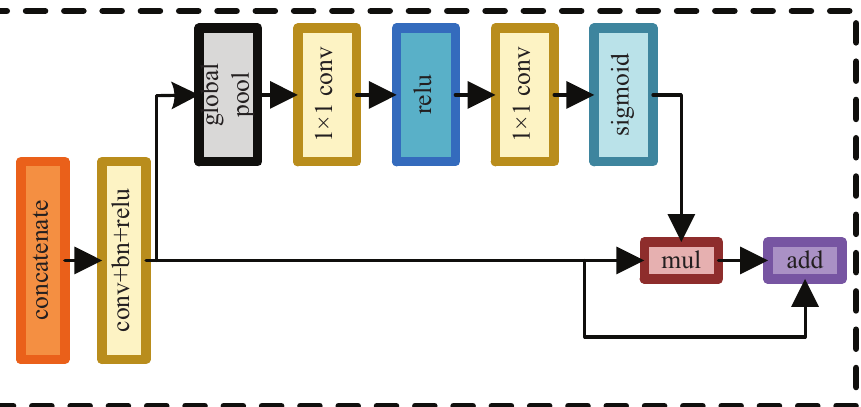
Figure 9. Feature fusion module. It is used to fuse the low-level features output by the spatial path with the high-level features output by the context path.